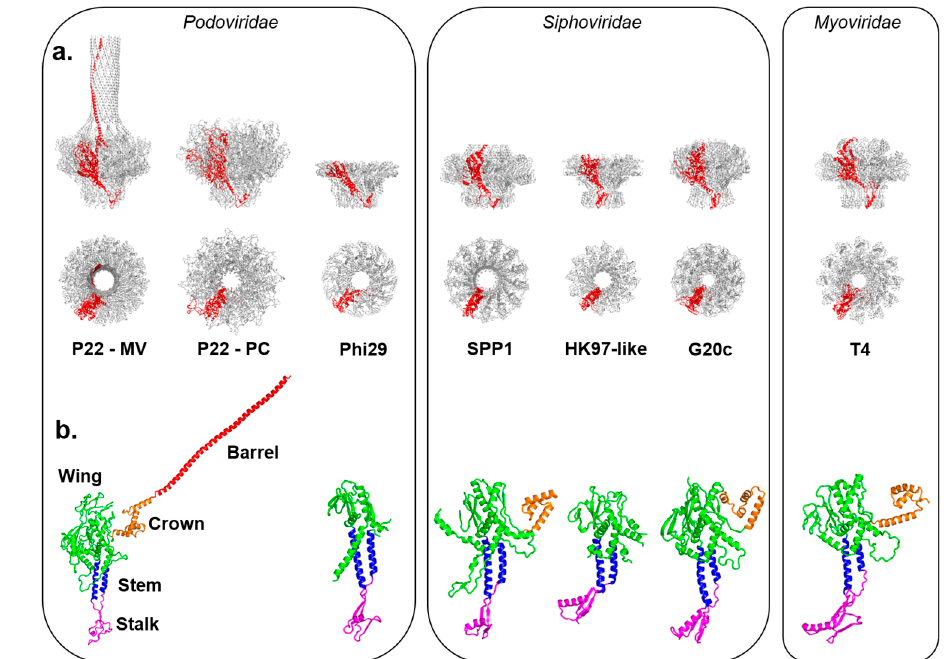
Figure 1. Crystal structures of in vitro assembled portal proteins deposited in the RCSB Protein Data Bank. ( a ) Quaternary structures of portal proteins from Podoviridae , Siphoviridae and Myoviridae shown as side and top views. All structures are aligned with respect to the Mature Virion (MV)-portal protein of P22 and are shown in scale with the protomer “A” colored in red and the rest of the oligomer in gray; ( b ) Tertiary structures of portal protein protomers color-coded to highlight the stalk (magenta), stem (blue), wing (green), crown (orange) and barrel (red). Except for P22 portal protein, which is shown only in the MV-conformation, all other portal protomers are in scale.